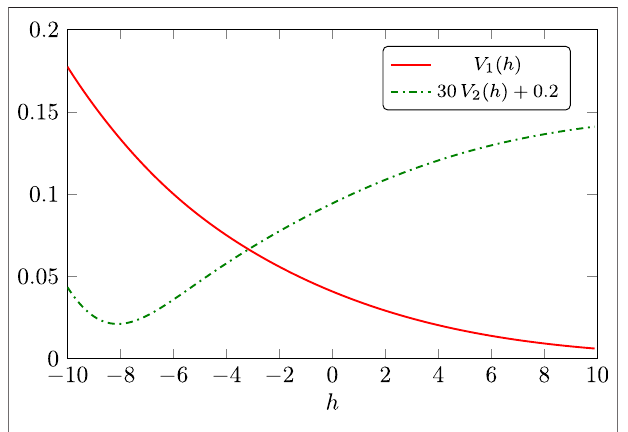
FIGURE 6 | Dimensionless fi xed-point fl uctuation potentials de fi ned via V (cid:2) V 1 ( h ) + Tr ( h 2 TL ) V 2 ( h ) , where h is the trace part and h TL is the traceless partofthe fl uctuationgraviton.Notethatwerescaledandshifted V 2 ,thatis, V 2 is small compared to V 1 and always negative. The results are taken from 205.